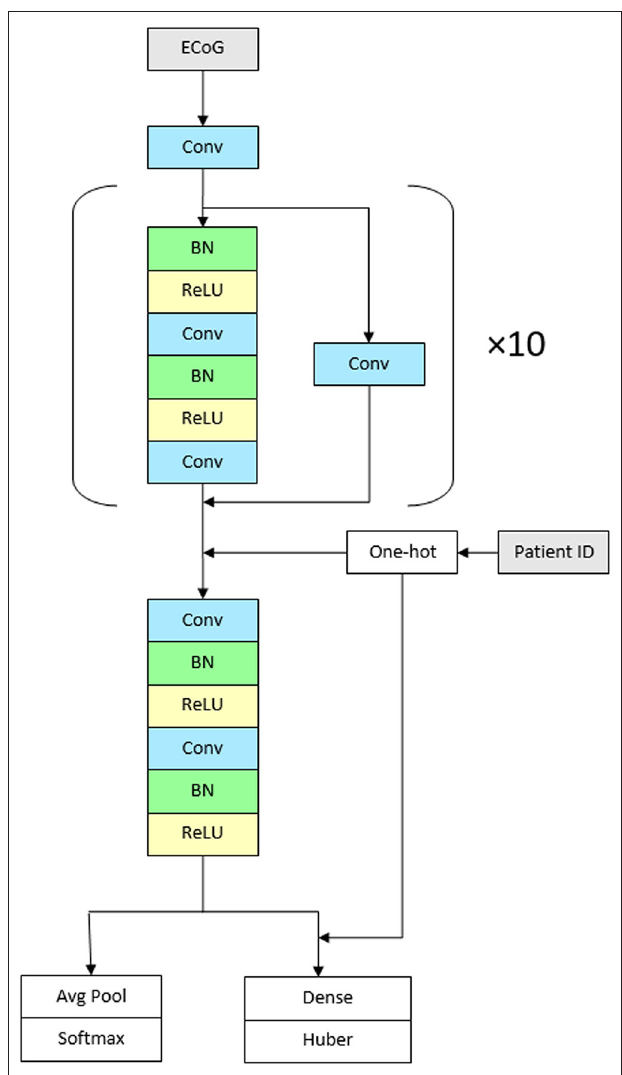
FIGURE 1 | Architecture of the network. The CNN contains 23 convolutional layers with residual connections. The network takes as input a time-series of intracranial voltage measurements and a patient identifier. Before each convolutional layer, batch normalization is applied followed by rectified linear activations. The network contains 11 residual blocks with 2 one-dimensional convolutional layers per block. The convolutional kernel size is 16. The number of filters is 16 in the first layer and increases linearly to 116 in the penultimate residual block. The network outputs two predictions: a probability that the recording contains an ictal pattern, and the onset time of the ictal pattern in seconds (Conv, convolutional layer; BN, batch normalization; ReLU, rectified linear